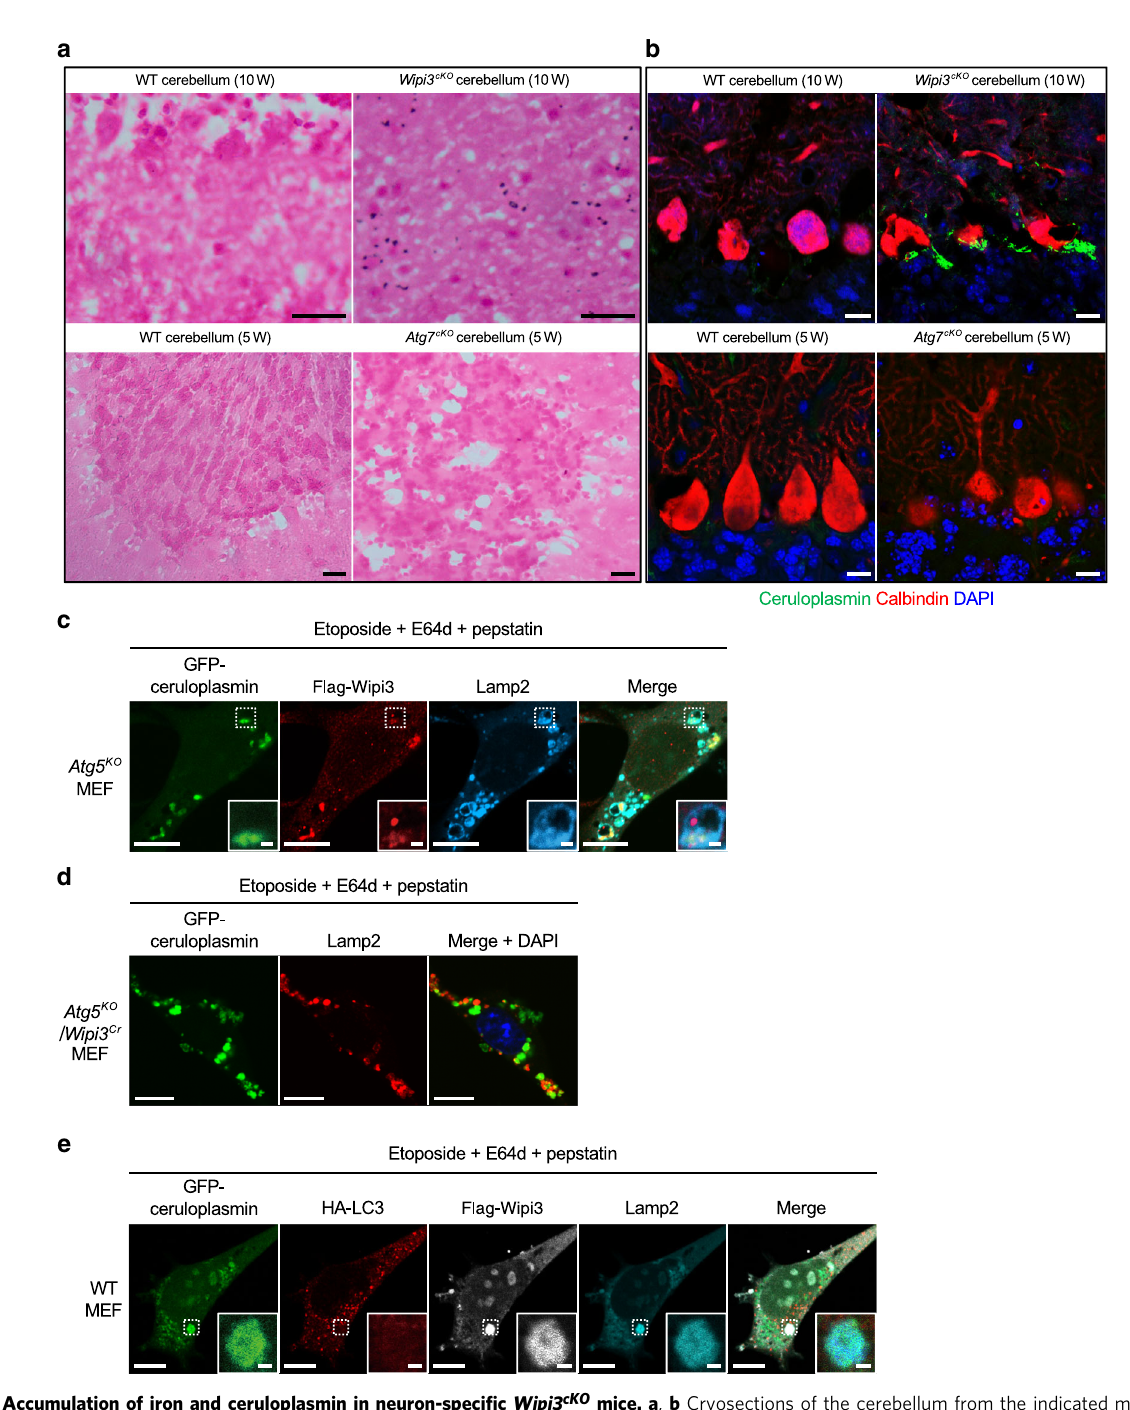
Fig. 8 Accumulation of iron and ceruloplasmin in neuron-speci fi c Wipi3 cKO mice. a , b Cryosections of the cerebellum from the indicated mice were stained with Prussian blue ( a ) and were immunostained with anti-ceruloplasmin (green) and anti-calbindin (red) antibodies ( b ). Bars = 20 µ m ( a ) and 10 µ m ( b ). Blue puncta indicate iron deposition in ( a ). ( c ) Atg5 KO MEFs expressing GFP-ceruloplasmin and Flag-Wipi3 were treated with etoposide (10 µ M) for 12 h in the presence of E64d and pepstatin. Then, cells were immunostained with anti-Flag (red) and anti-Lamp2 (blue) antibodies. Bars = 10 µ m. Magni fi ed images of the dashed squares are shown in the insets. Bars = 1 µ m. Ceruloplasmin is incorporated into Wipi3-positive large Lamp2 puncta in Atg5 KO MEFs. d A similar experiment to ( c ) was performed using Atg5 KO /Wipi3 Cr MEFs. Bars = 10 µ m. e WT MEFs expressing GFP-ceruloplasmin, HA- LC3, and Flag-Wipi3 were treated with etoposide (10 µ M) for 12 h in the presence of E64d and pepstatin. Then, cells were immunostained with anti-HA (red), anti-Flag (white), and anti-Lamp2 (blue) antibodies. Bars = 10 µ m. Magni fi ed images of the dashed squares are shown in the insets. Bars = 1 µ m. LC3 is not colocalized with ceruloplasmin/Wipi3-positive large Lamp2 observed in the neurons of Wipi3 cKO mice. In mice, cerebellar diseases. Taken together, we here identi fi ed Wipi3 as a molecule damage is prominent, and hence wipi3 mutations are expected to essential for alternative autophagy, and also showed its impor- be identi fi ed as the cause of yet-uncharacterized cerebellar tance in the maintenance of neurons.